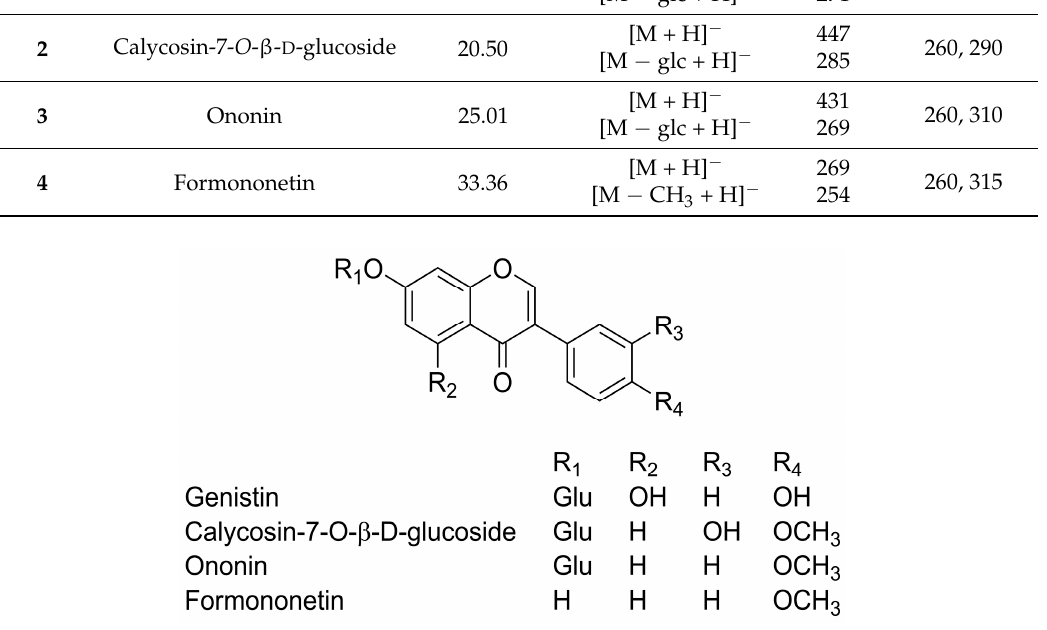
Figure 9. The chemical structures of four investigated compounds.